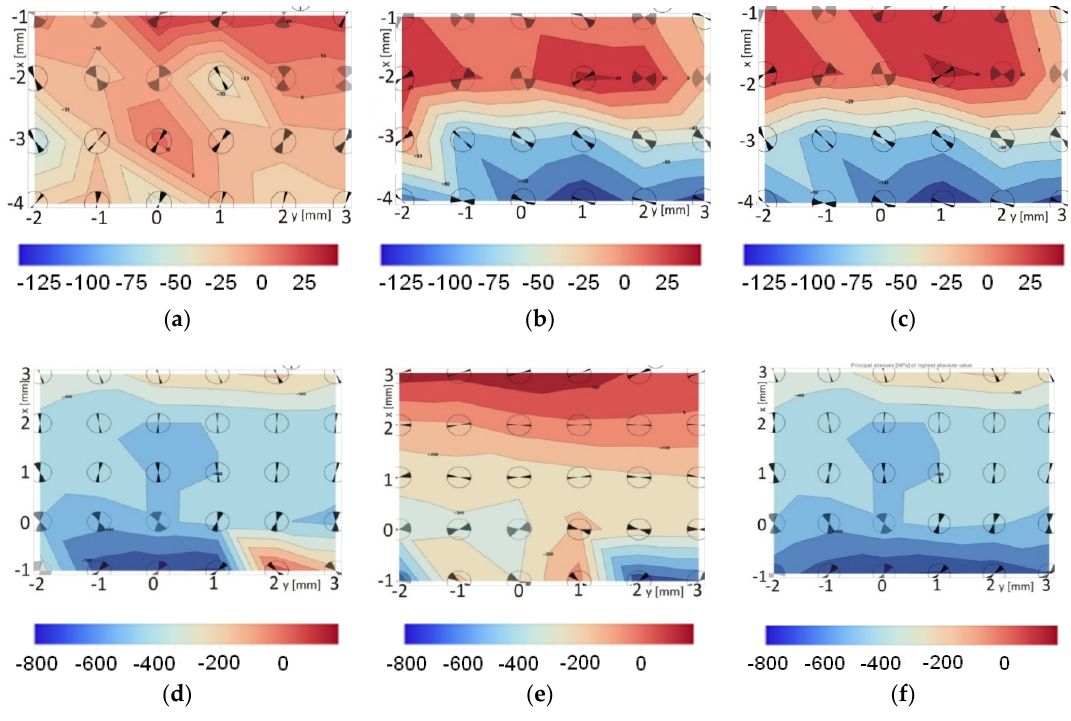
Figure 9. Distribution of residual stress in a sample made of the AA2519-AA1050-Ti6Al4V laminate after explosive joining: AA2519 stresses in vertical direction ( a ), AA2519 stresses in the horizontal direction ( b ), AA2519 principal stresses ( c ), Ti6Al4V stresses in vertical direction ( d ), Ti6Al4V stresses in the horizontal direction ( e ), Ti6Al4V principal stresses ( f ),